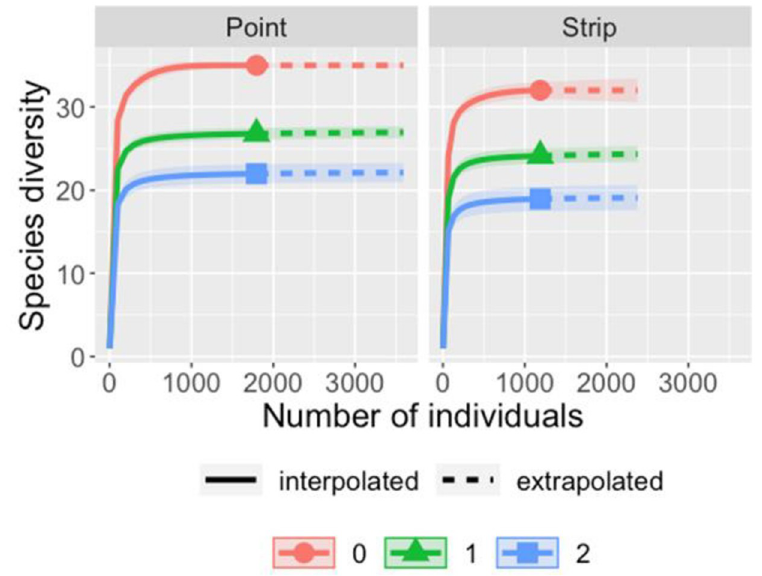
Fig 3. Species rarefaction plot for three hill numbers; q = 0 (Specie Richness); q = 1 (Shannon diversity); q = 2 (Simpson diversity) in the arid region of Rajasthan.